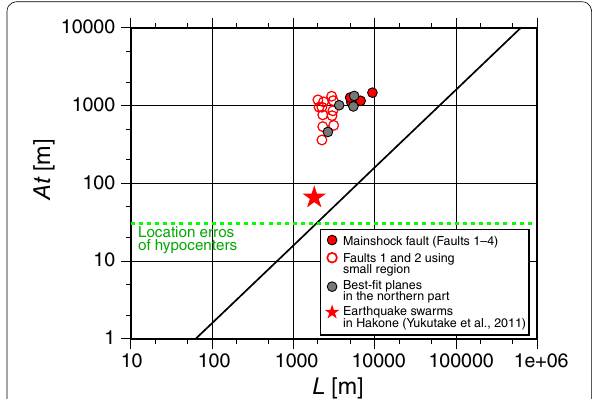
Fig. 9 Relationship between L and A t . The straight line indicates the scaling between P and L based on a natural fault zone in the outcrop compiled by Vermilye and Scholz (1998). The solid red and gray circles indicate A t around the mainshock fault (Faults 1 through 4) and the best-fit planes in the northern part of the aftershock region (Faults 5 through 8), respectively. The red open circles indicate A t obtained using a smaller region for event selection around Faults 1 and 2. The green broken line indicates the upper limit of the location errors of hypocenters in the horizontal direction. The red star indicates the thickness of the hypocenter distribution and its fault length associ- ated with the swarm activity in the volcanic area (Yukutake et al.